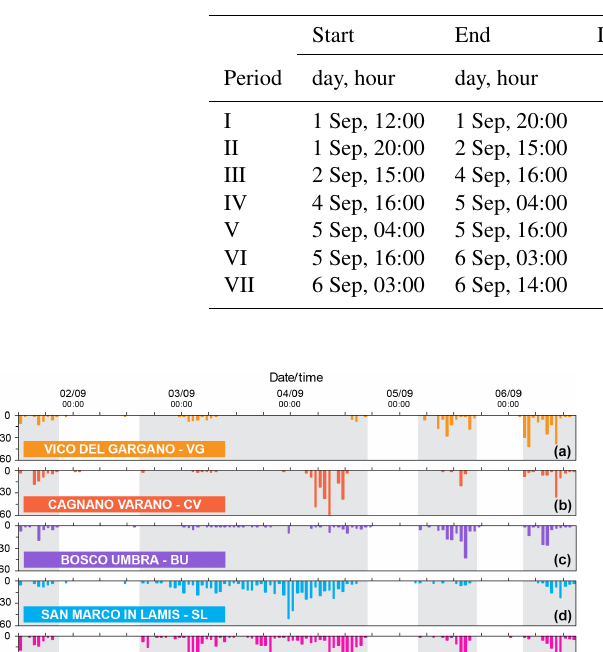
Table 1. Characteristics of seven periods in the sequence of rainfall events that hit the Gargano Promontory between 1 and 6 September 2014. Start and end times are given in UTC + 2. Rain/dry lists rainfall, wet (R) and no-rainfall, dry or nearly dry (D), periods. Rainfall gives the range (minimum–maximum) of the cumulated rainfall in each period. Intensity is the average intensity in the period for the maximum cumulated rainfall. See also Figs. 3 and 7.